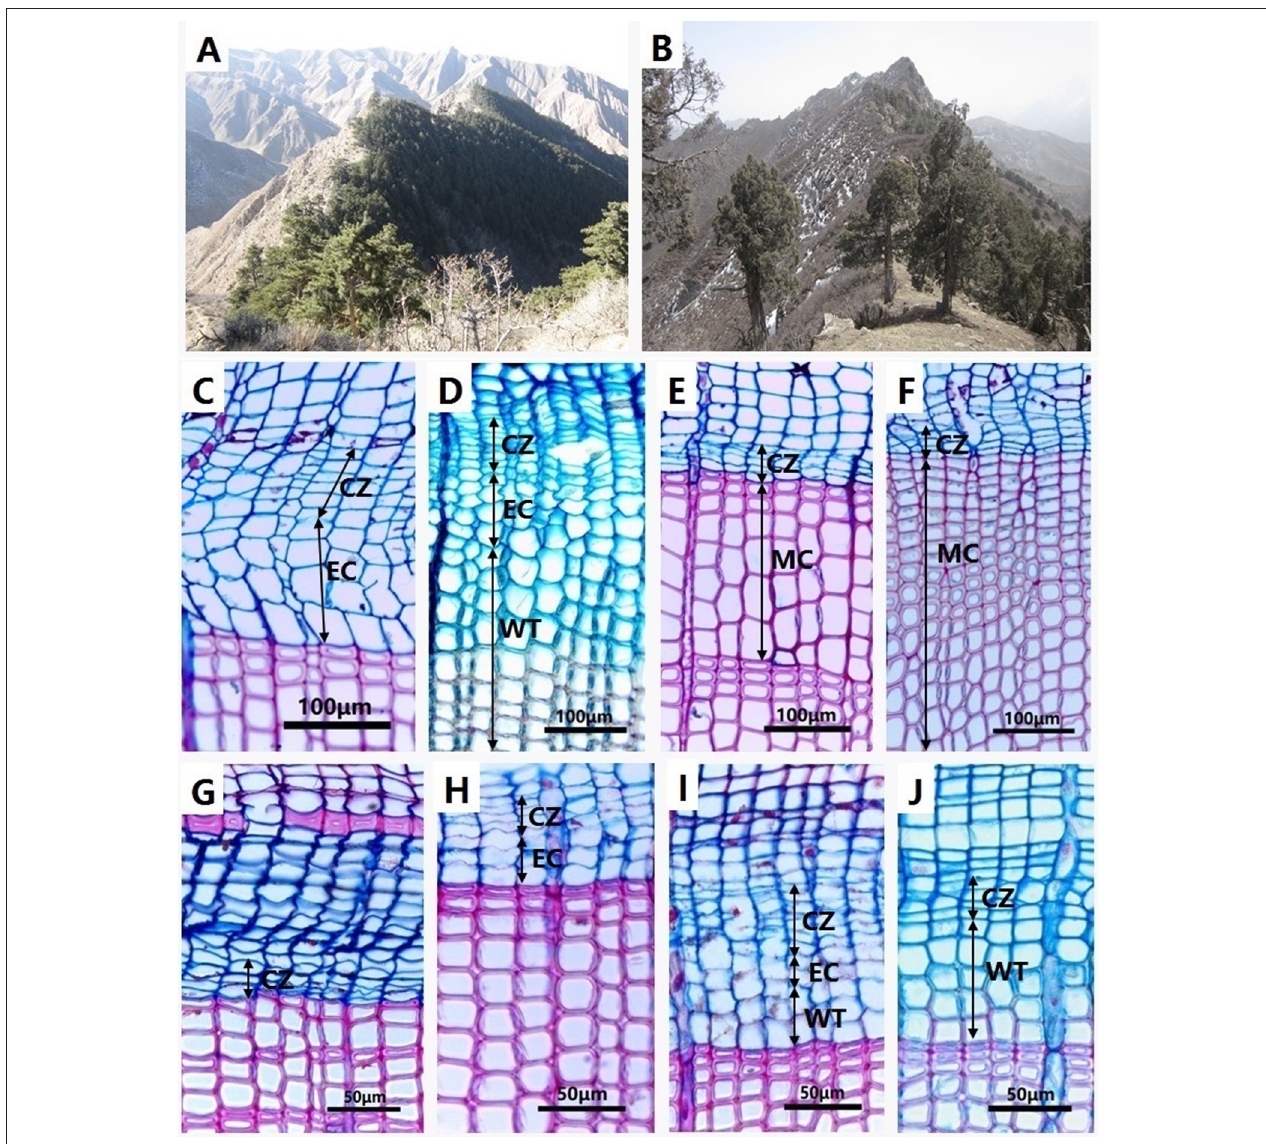
FIGURE 1 | Chinese pine ( Pinus tabulaeformis ) forest in HSM (A) and Qilian juniper ( Juniperus przewalskii ) forest in SDL (B) . (C) Active cambium (CZ) and enlarging cells (EC) of big-old pines on 13 June. (D) Enlarging (EC) and wall-thickening (WT) cells of small-young pines on 12 July. (E) Mature cells (MC) of big-old pines on 29 August. (F) Mature cells (MC) of small-young pines on 2 September. (G) Dormant cambium (CZ) of big-old junipers on 12 May. (H) Enlarging cells (EC) of small-old junipers on 8 June. (I) Enlarging (EC) and wall-thickening cells (WT) of big-old junipers on 9 July. (J) Wall-thickening cells (WT) of small-old junipers on 21